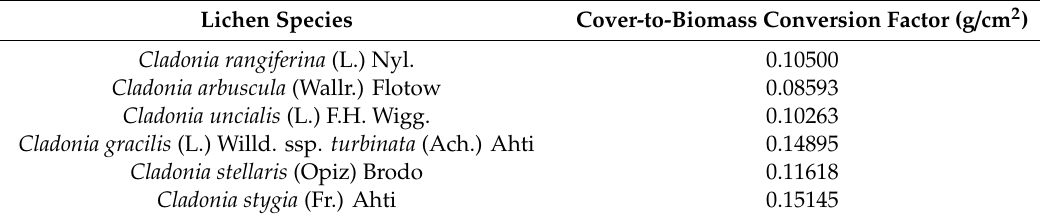
Table 1. Cover-to-biomass (g / cm 2 ) conversion factors for the six most common Cladonia spp. ground lichens found in northwestern Ontario, Canada. Species classification and conversion factors are from McMullin et al. (2011) [33].